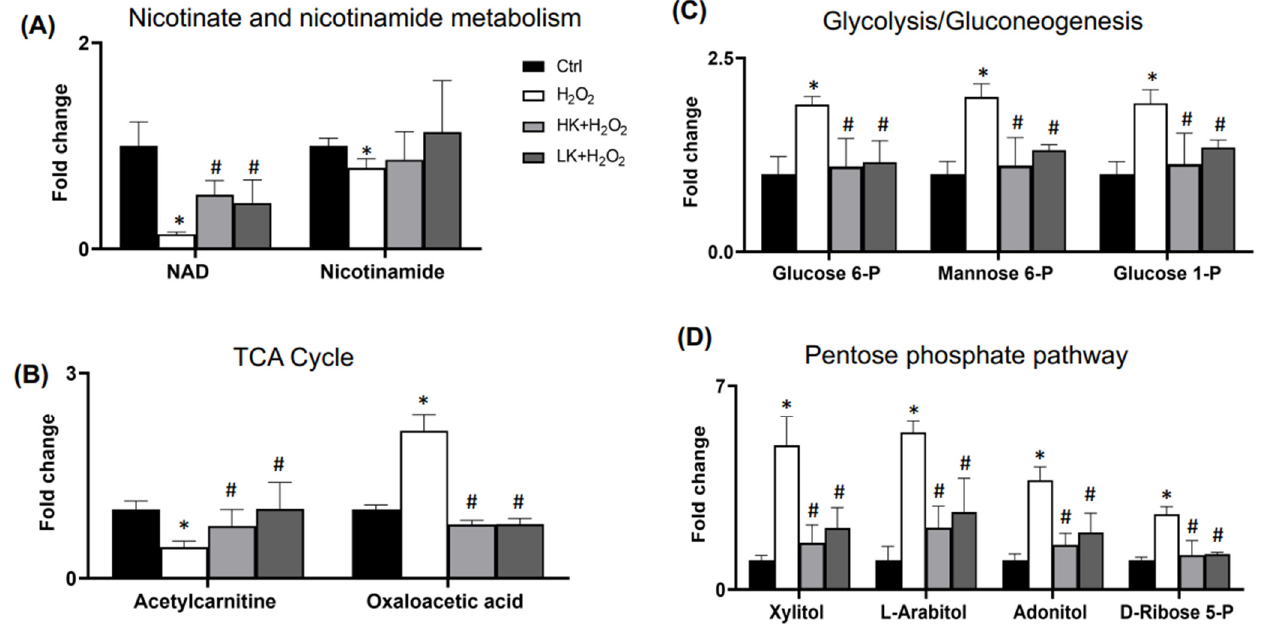
Figure 5. HK or LK Protects against H 2 O 2 from Inducing Changes in the Metabolites. The metabo- lites altered by H 2 O 2 treatment belonging to nicotinate and nicotinamide metabolism, TCA cycle, glycolysis/gluconeogenesis, and pentose phosphate pathway were analyzed for the protective effect of HK or LK cardioplegia solution. * indicates significant difference (n = 4, p < 0.05) between control and H 2 O 2 -treated cells, whereas # indicates significant difference (n = 4, p < 0.05) between HK or LK with H 2 O 2 treatment in comparison with H 2 O 2 treatment alone. These data were analyzed for the significant differences by one-way ANOVA using GraphPad Prism 9 software.